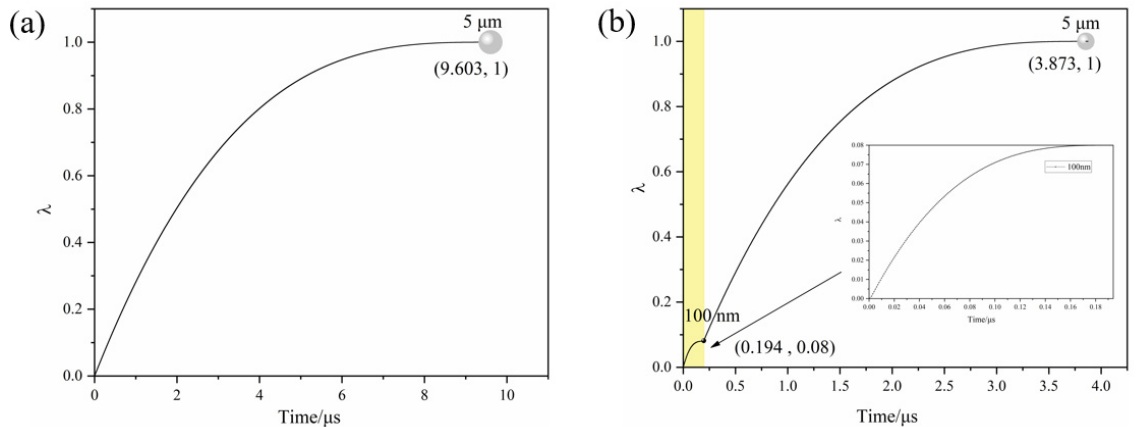
Figure 12. The reaction degree calculation results of the micron-sized aluminum powder ( a ) and the micro-nano composite aluminum powder ( b ).